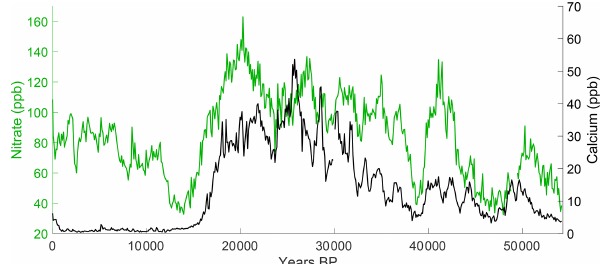
Figure 12. Nitrate and calcium concentrations in SPICEcore. There is low centennial-scale correlation ( r = 0 . 26; p < 0 . 01) between calcium and nitrate ions during the Holocene, when accumulation is the dominant control on nitrate concentration (Fig. 11). During the Pleistocene, centennial median nitrate and calcium are positively correlated ( r = 0 . 80; p < 0 . 01). Figure 13. Results from three firn models compared with δ 15 N–N 2